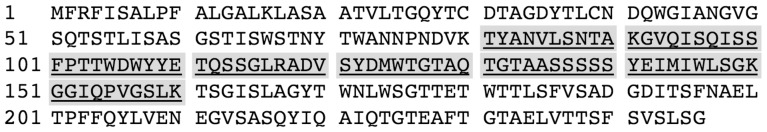
Mass spectrometric analysis of purified GtCel12A.Primary sequence of GtCel12A is shown with the peptides identified by LC-MS evidenced in gray.